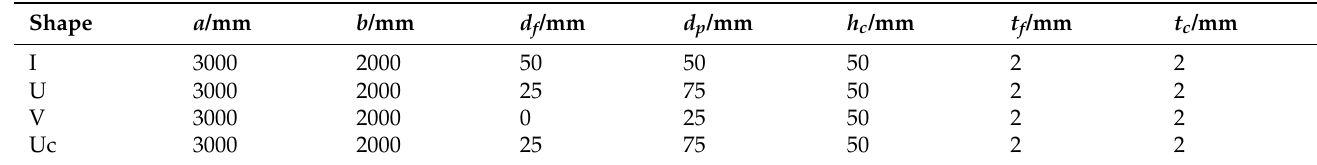
Table 3. Dimensions of the I-, U-, V-, and Uc-type metal sandwich